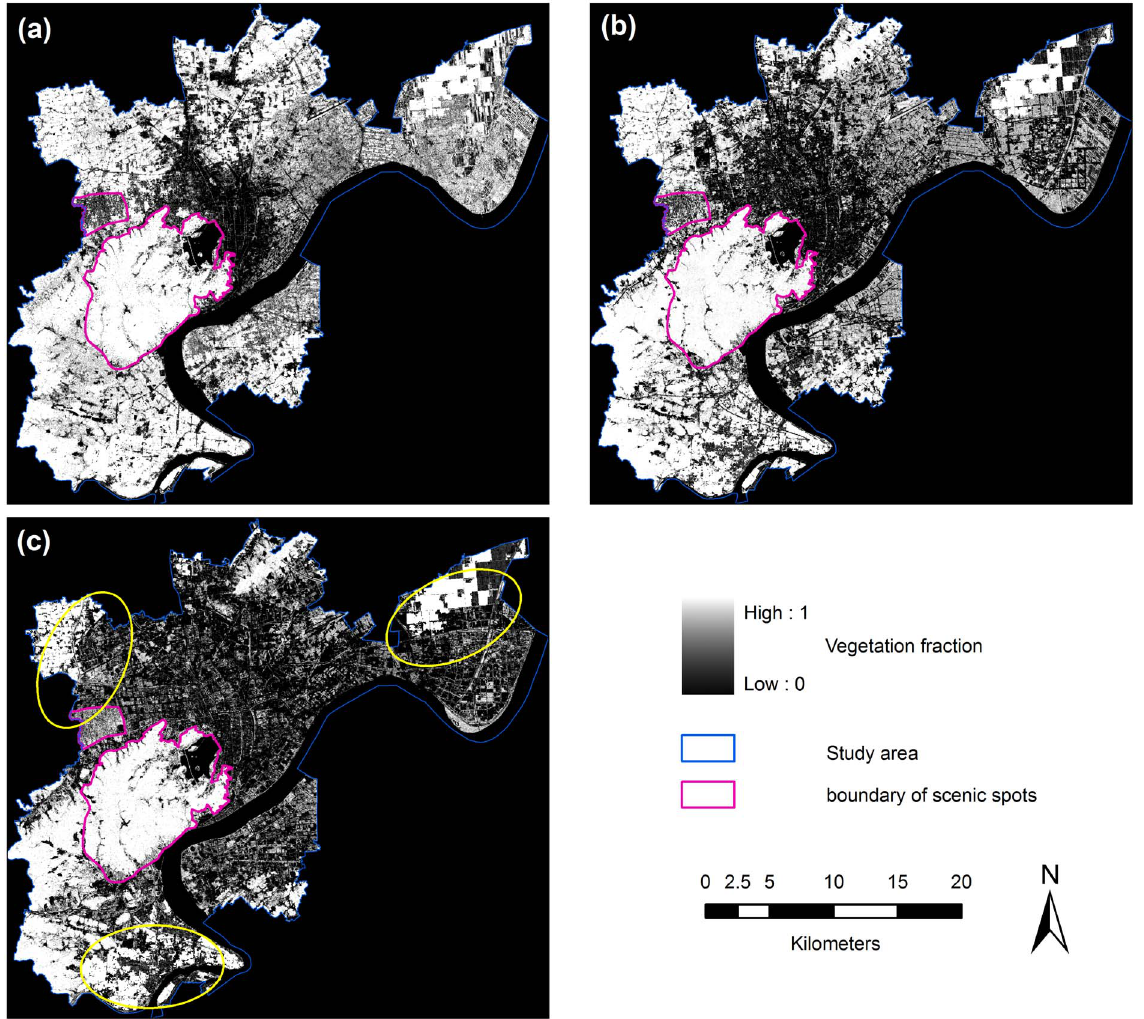
Figure 2. Vegetation fraction maps of Hangzhou for (a) 1990, (b) 2002, and (c) 2010. The vegetation fractions are indicated by the grayscale, where 1 represents pure vegetation (light gray) and 0 represents no vegetation (dark gray) in each pixel.